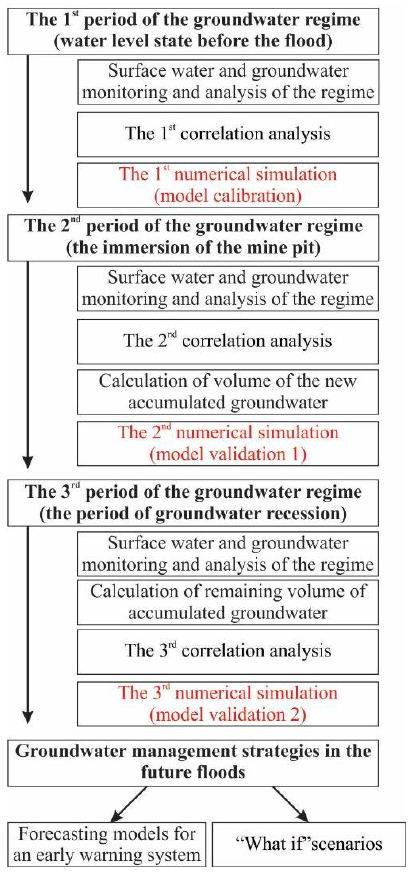
Figure 8. Operational research algorithm.